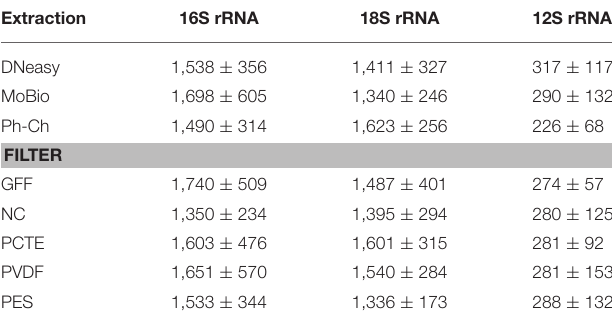
TABLE 3 | Number of OTUs per treatment and genetic marker with their respective standard